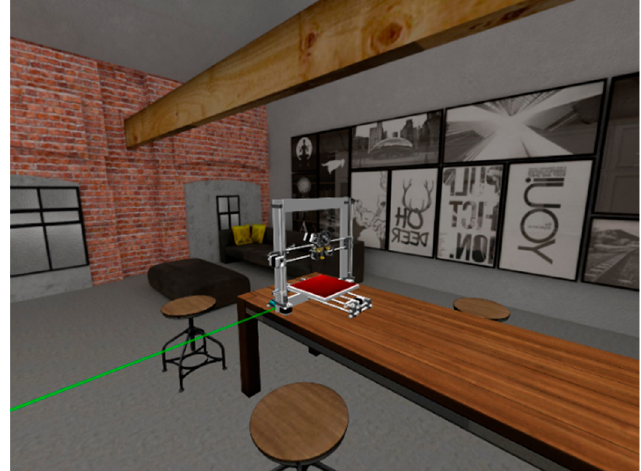
Figure A3. The 3D printing to fabricate the chosen object.